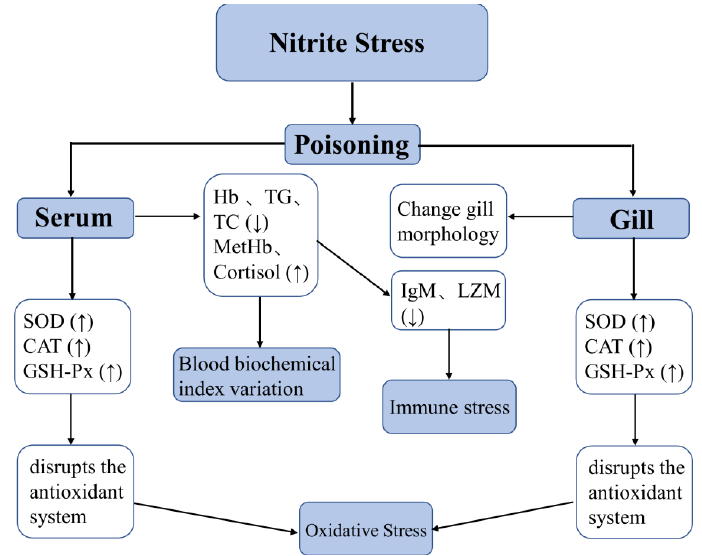
Figure 8. The graphical abstract of the nitrite-induced toxic effect in large yellow croaker via gill and blood. ↑ : increase, ↓ : decrease.